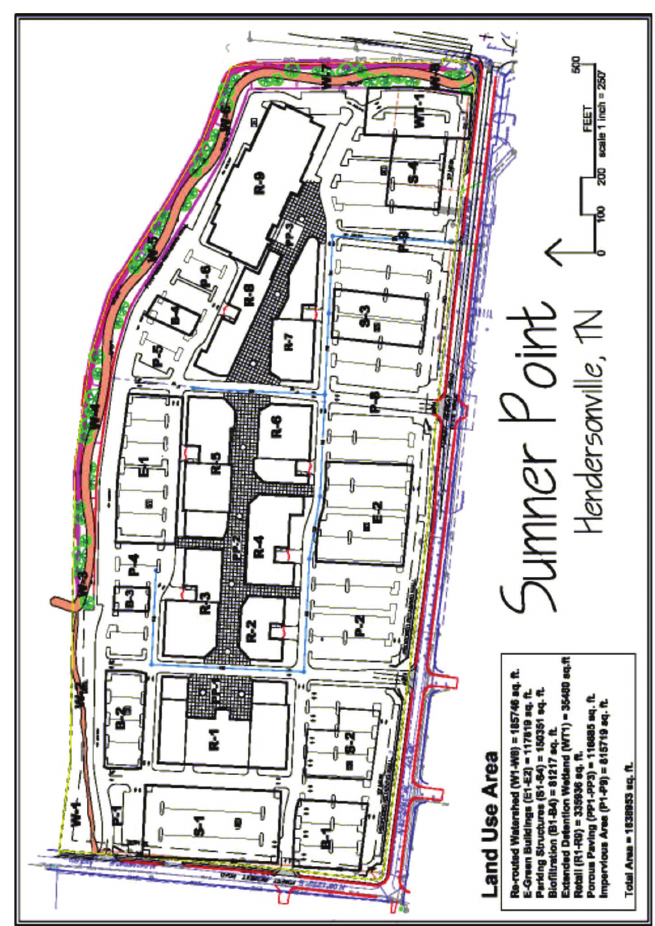
Figure 11: Sumner Point Site Plan (Source: